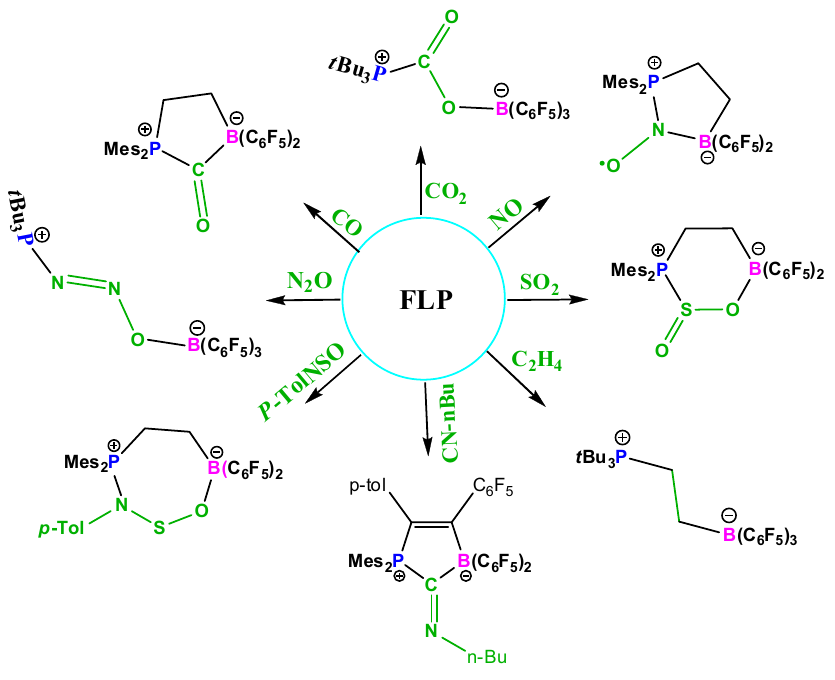
Figure 7. Some examples of small molecule activation by FLPs.